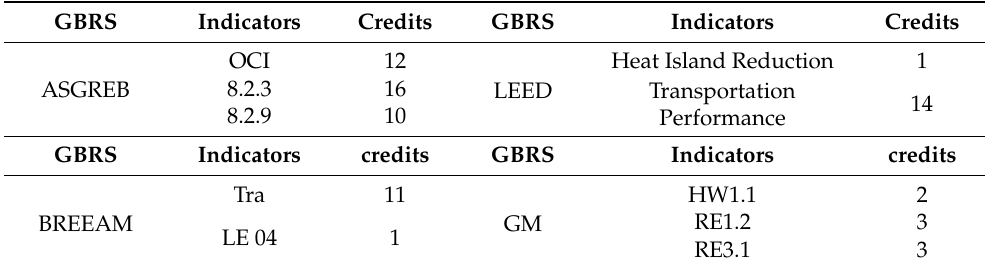
Table 9. Site scope CO 2 -related indicators